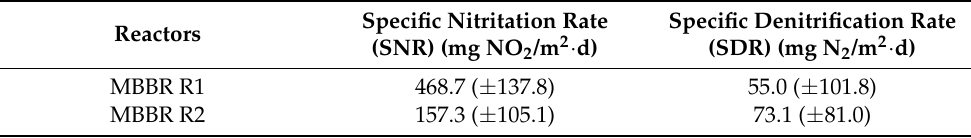
Table 2. The specific nitritation and denitrification in MBBR R1 and MBBR